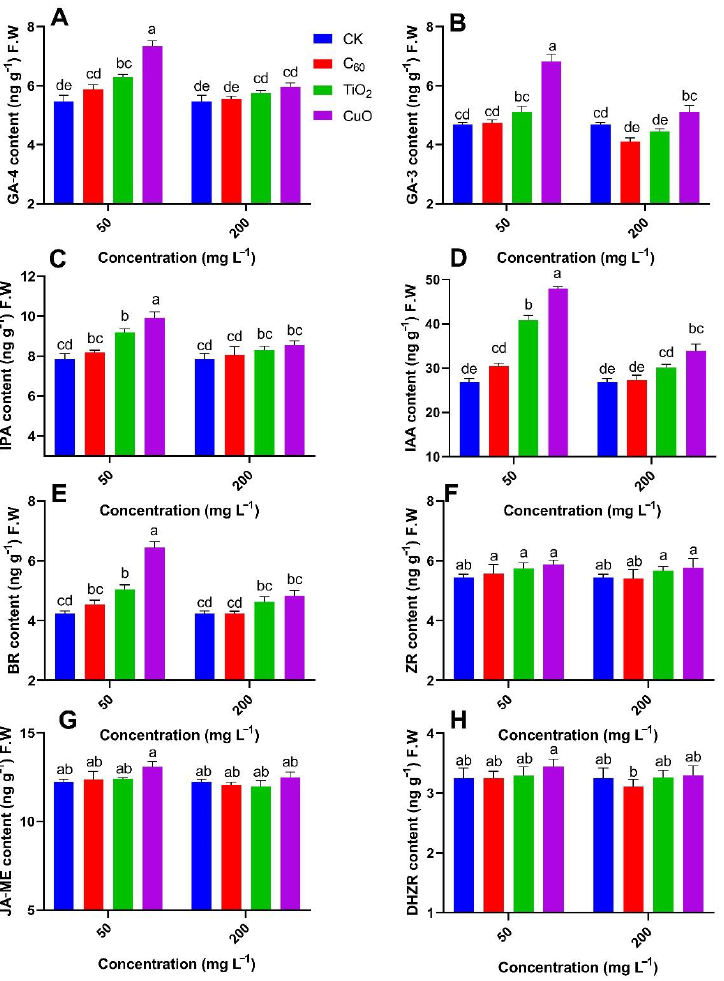
Figure 5. Effect of different NMs on the mean contents (n = 3) of ( A ) gibberellic acid-4, ( B ) gibberellic acid-3, ( C ) indolepropionic acid, ( D ) indole-3-acetic acid, ( E ) brassinolide, ( F ) zeatin riboside, ( G ) methyl jasmonate, and ( H ) dihydrozeatin riboside hormones in sweet potato cultivar (Y25) exposed to soft rot disease. Different small letters represent significant difference according to Duncan’s multiple range test ( p < 0.05. n = 3).